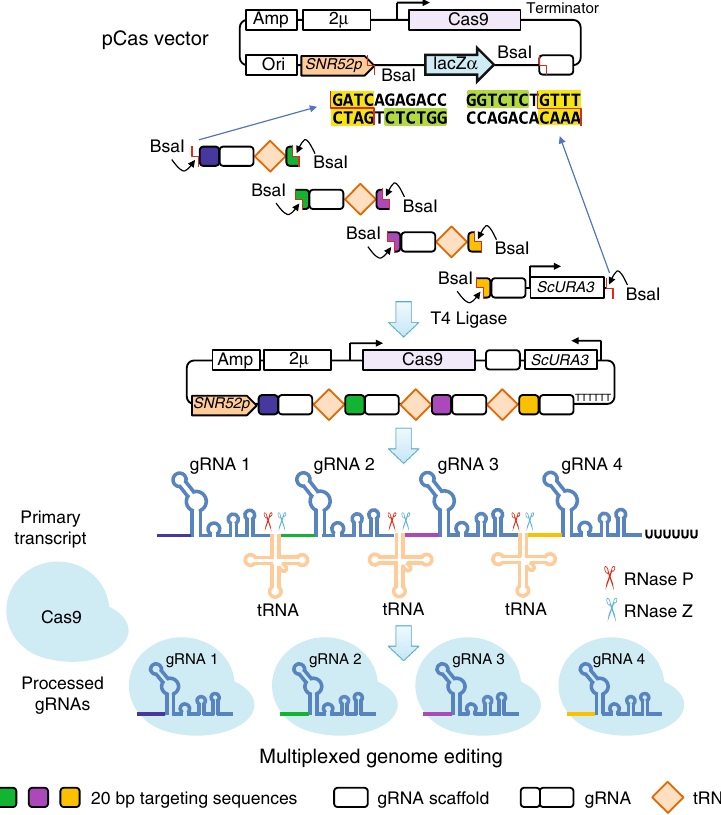
Fig. 1 The GTR-CRISPR for multiplexed genome editing in S. cerevisiae . The GTR-CRISPR plasmid is constructed by Golden Gate assembly of PCR-generated fragments containing Cas9, gRNA-tRNA-array cassette, and a S. cerevisiae URA3 gene with the truncated promoter. After transformed to yeast, the primary RNA transcript is cleaved by yeast endogenous tRNA-processing enzymes, RNase P and Z, leaving functional guide RNAs for genome